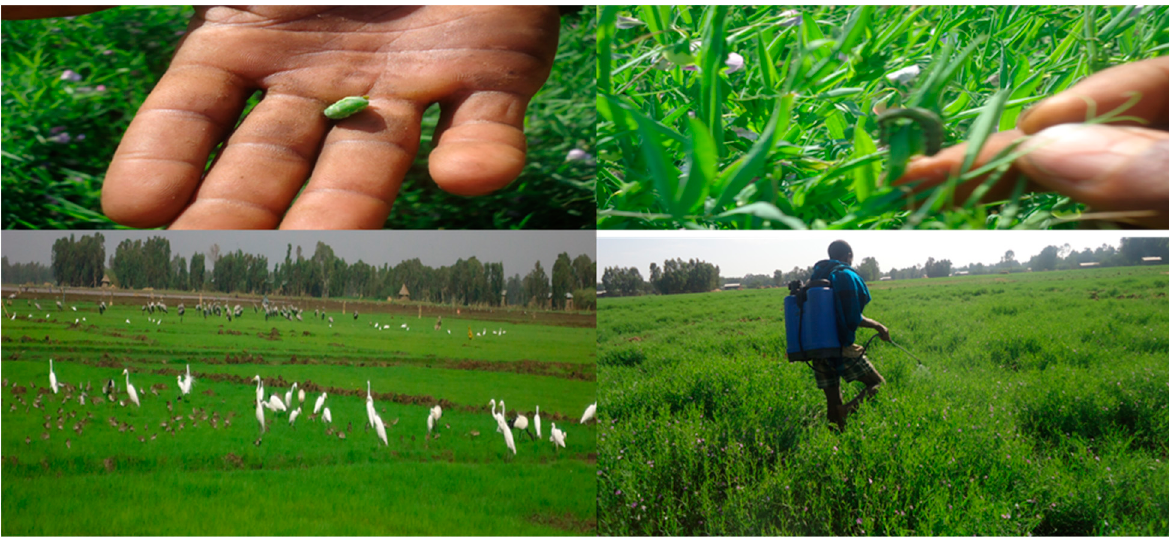
Table 6. Negative impacts of application of agricultural inputs.